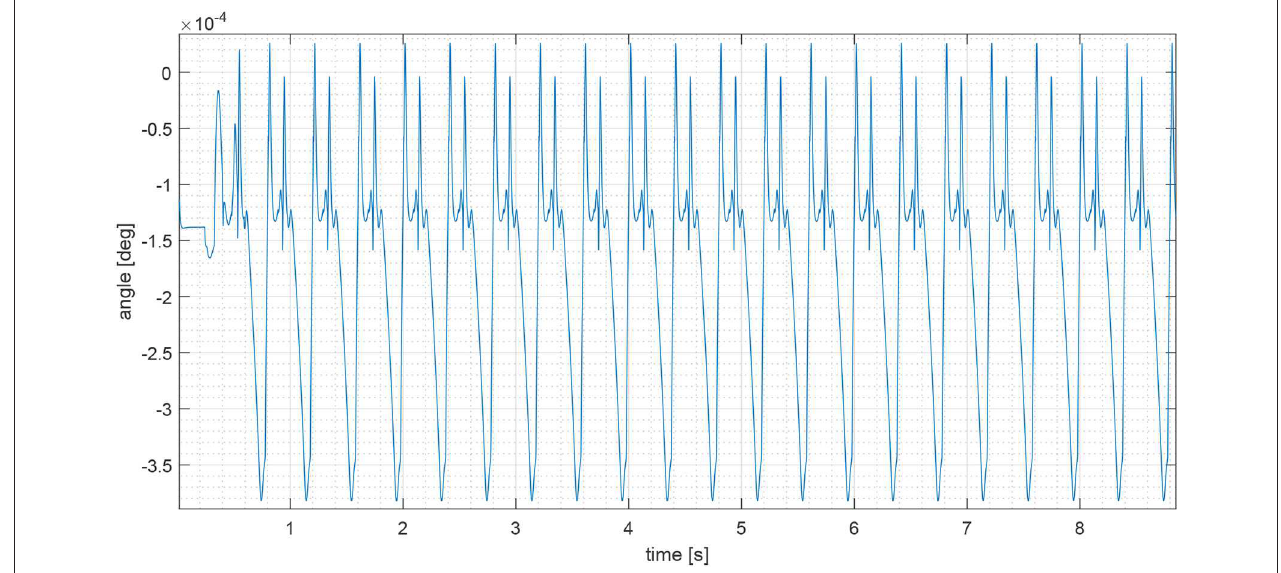
FIGURE 9 | Spine oscillation, TEST 1 (x axis).